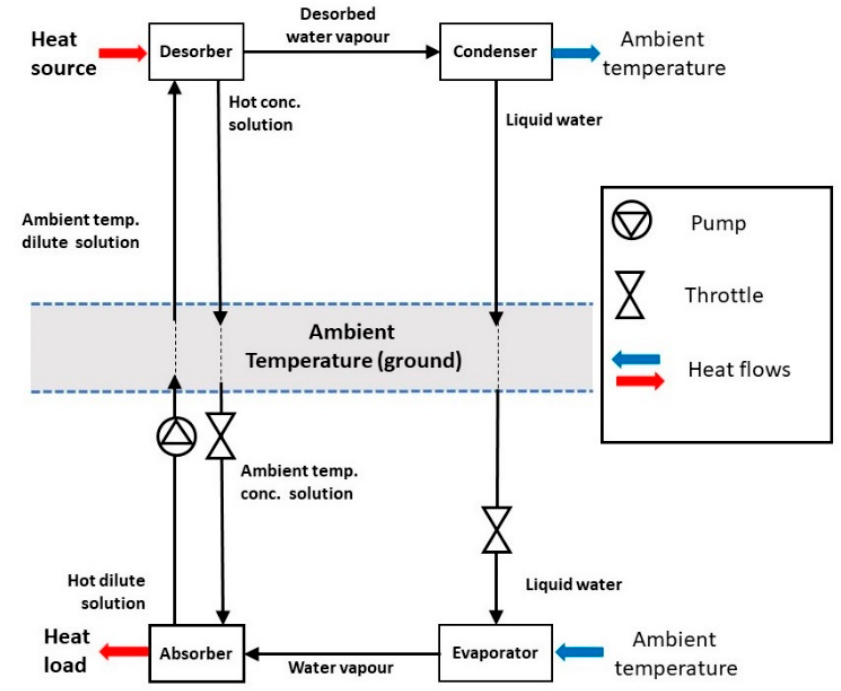
Figure 1. Basic heat transmission using absorption/desorption.